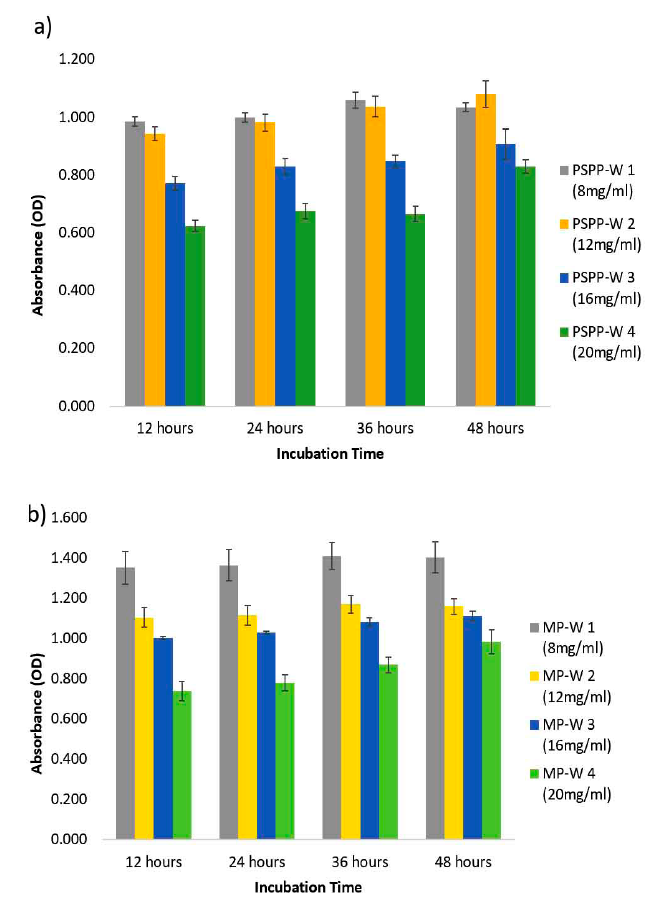
Fig. 4. Antibiofilm activity of aqueous extracts of a) Piper aduncum and b) Macaranga peltata against Staphylococcus